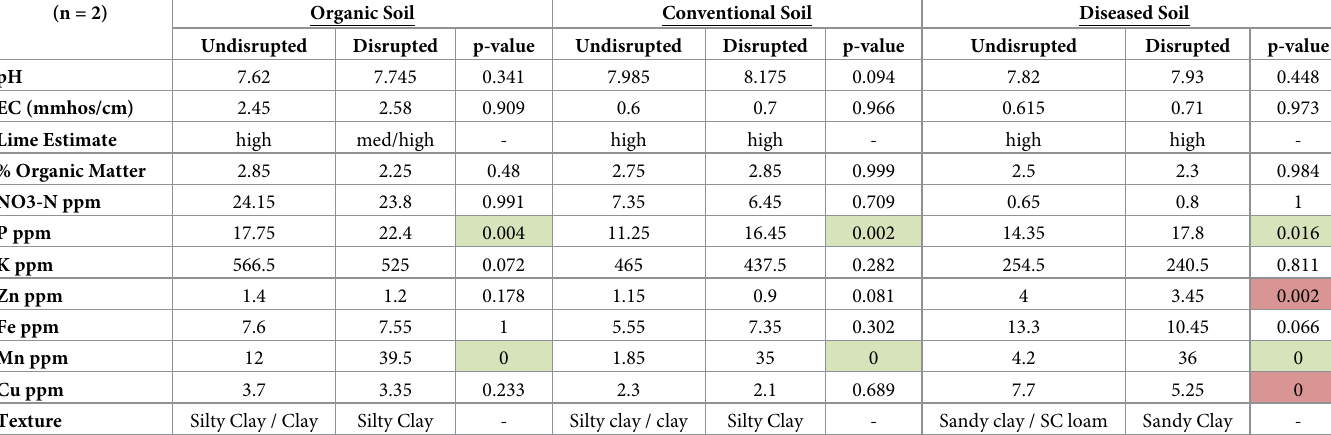
- Silty clay / clay Silty Clay - Sandy clay / SC loam Sandy